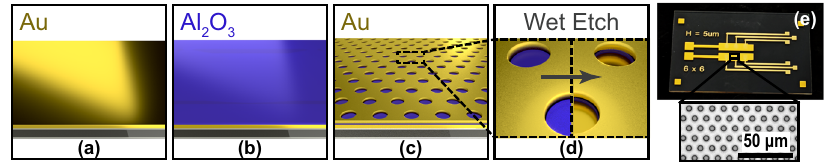
Fig. 5 | Metal-insulator-metal (MIM) nanogap device fabrication. Fabrication steps for the microhole array DEP device used for real-time wireless trapping and sensing experiments. a Step 1: Au is deposited to de fi ne the bottom